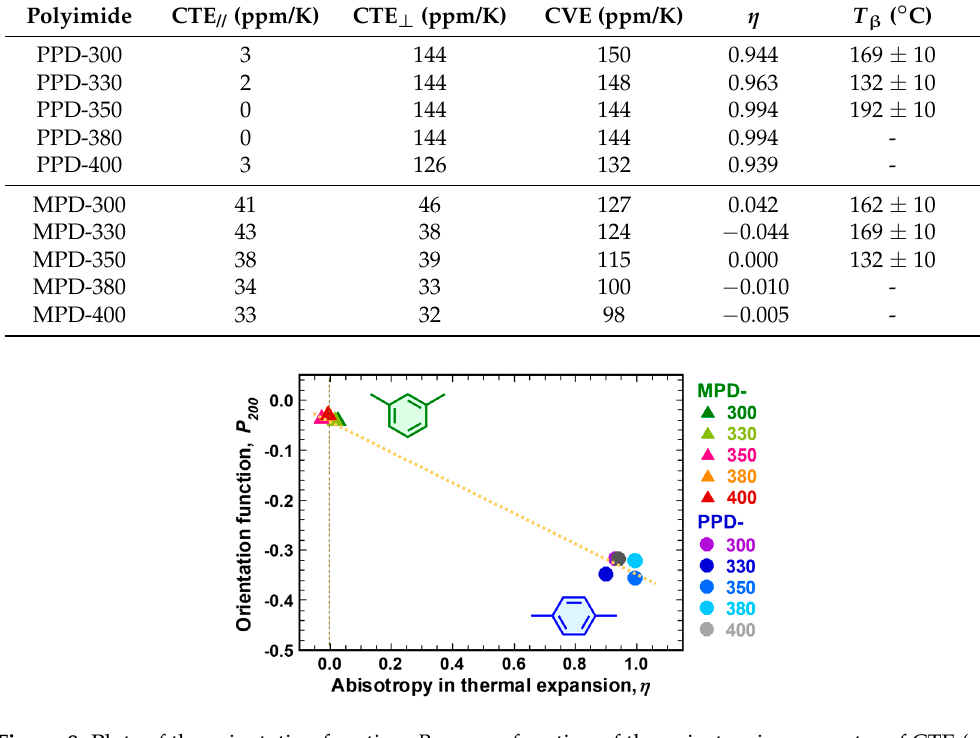
Figure 8. Plots of the orientation function, P 200 , as a function of the anisotropic parameter of CTE ( η ).